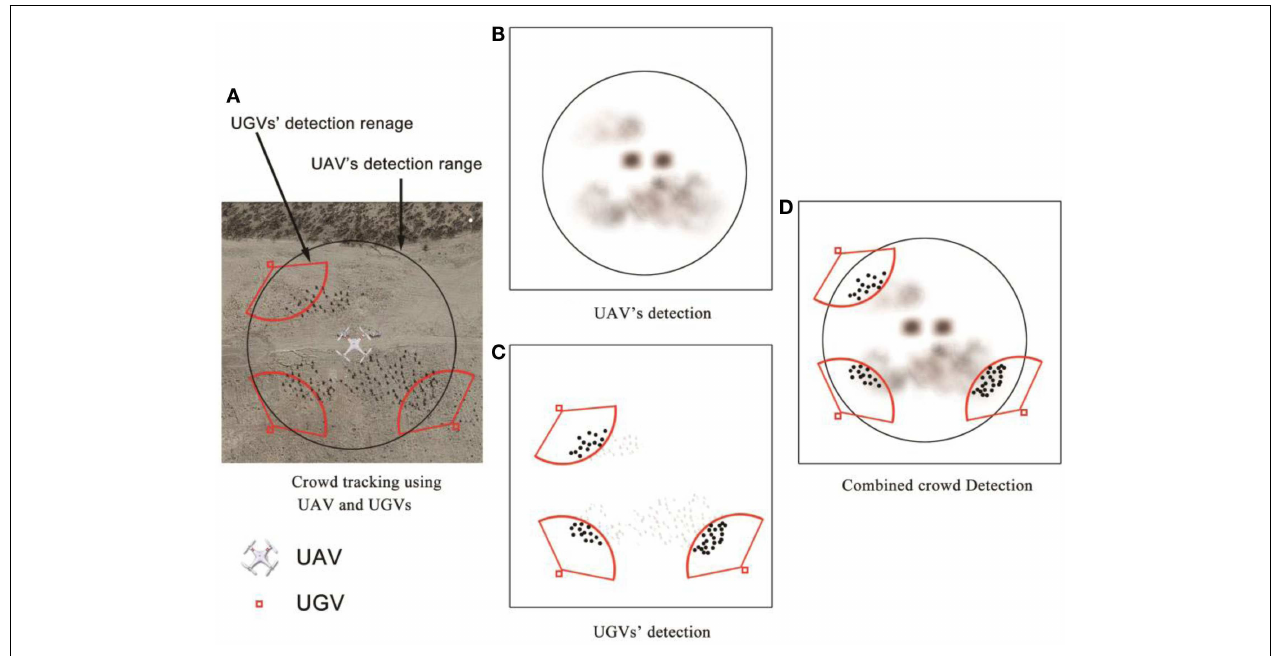
range. (B) Black cloud-like pixels represent the UAVs’ detection image. (C) Black dots represent the individuals detected by UGVs. (D) Dots and cloud-like pixels represent aggregated information from both UAV and